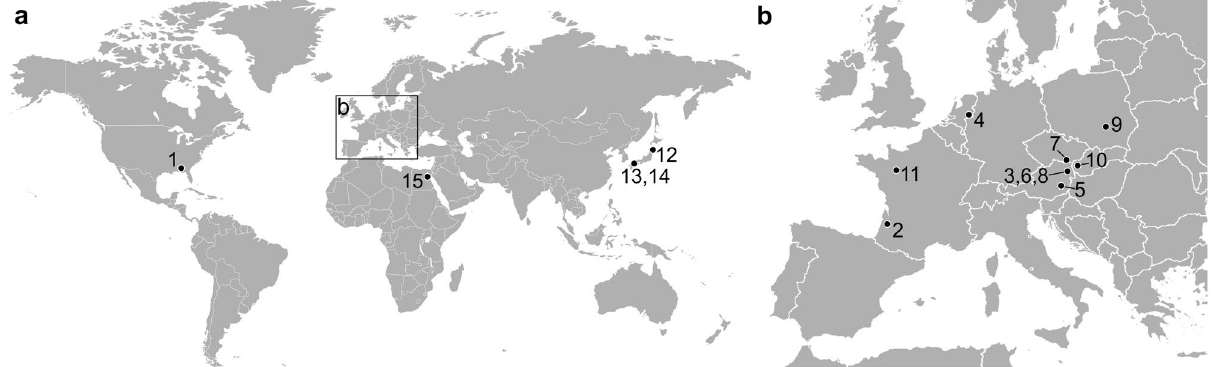
Figure 2. Geographical distribution of fossil specimens incorporated into this study. The numbers indicate the localities of the specimens listed in Table 1. ( a ) Localities in America, Africa, and Asia. ( b ) Localities in Europe. The maps are modified templates (http://www.freepik.com/free-vector/gray-world-map_788336.htm, https:// commons.wikimedia.org/wiki/File:BlankEurope.png).